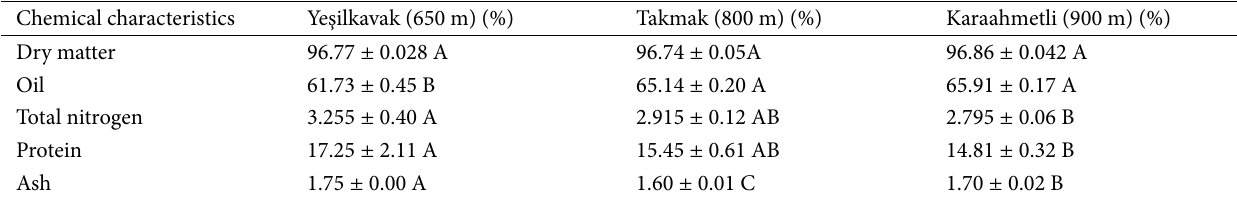
Table 2 Changes in some chemical parameters of ‘Chandler’ walnuts according to growing altitude. Chemical